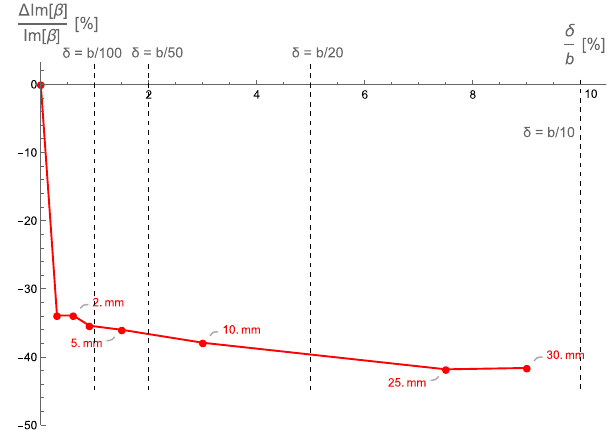
FIG. 7. Effect of varying screen thickness δ from zero to ∼ b= 10 (that is 0.0 – 30.0 mm) on Im ½ β 0 (cid:2) , for the Scale-3 structure with period b ¼ 333 . 33 mm, calculated at pSteps=nSteps ¼ 6666 = 3333 . Selected points on the curve give explicit value of δ in mm. See data in Table II for details.